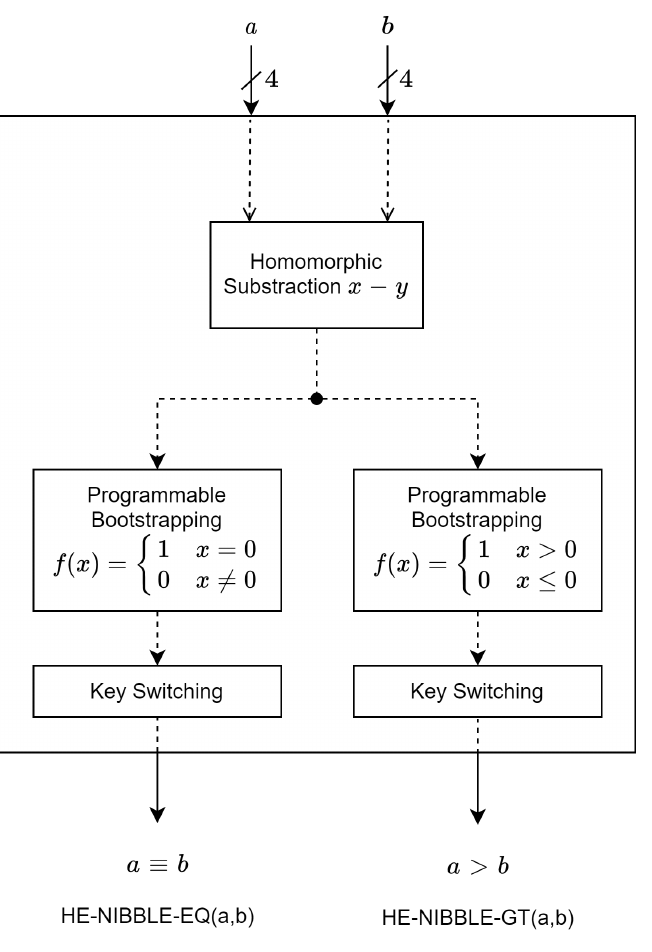
Figure 5. Encrypted nibble comparator: HE-N IBBLE -E Q and HE-N IBBLE -G T